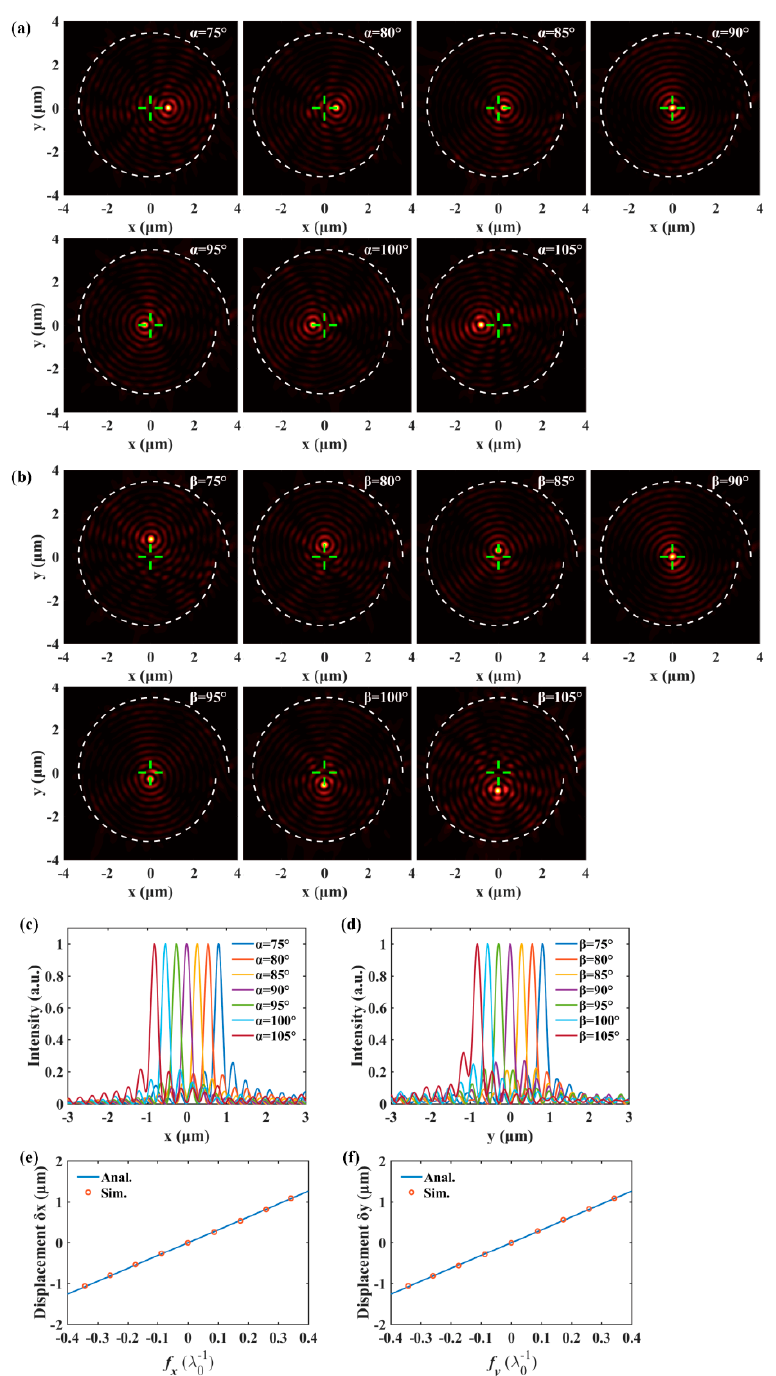
Figure 2. ( a , b ) show that the SPPs’ focus will shift transversally or longitudinally when the spatial frequency component f x or f y changes. ( c , d ) are the profiles of the SPPs’ focus generated by light with different incident angles. ( e , f ) compare the theoretical displacements of SPPs’ focus with the simulated values.